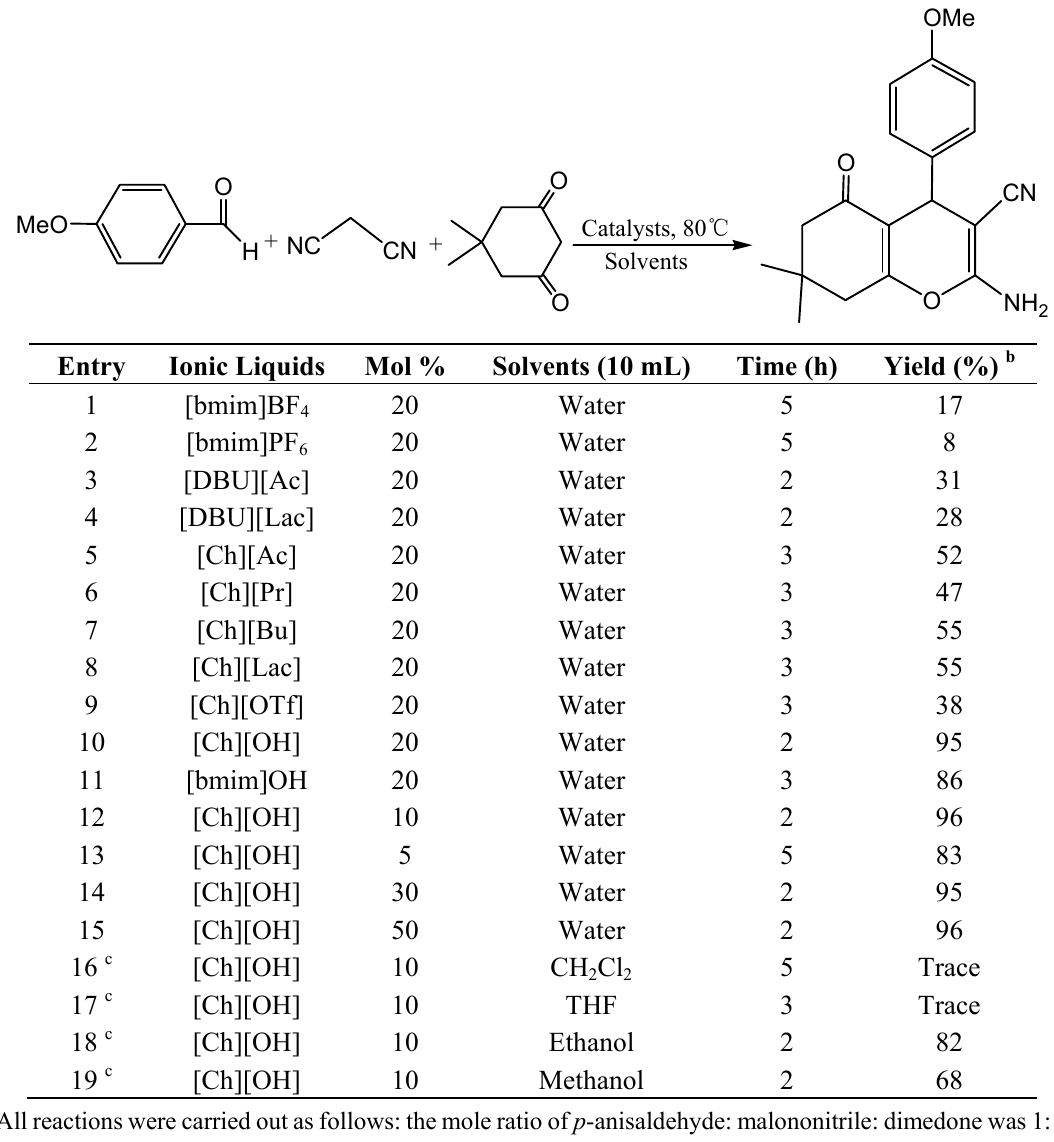
Table 1. Optimization of reaction conditions for the synthesis of tetrahydrobenzo[ b ]pyran a